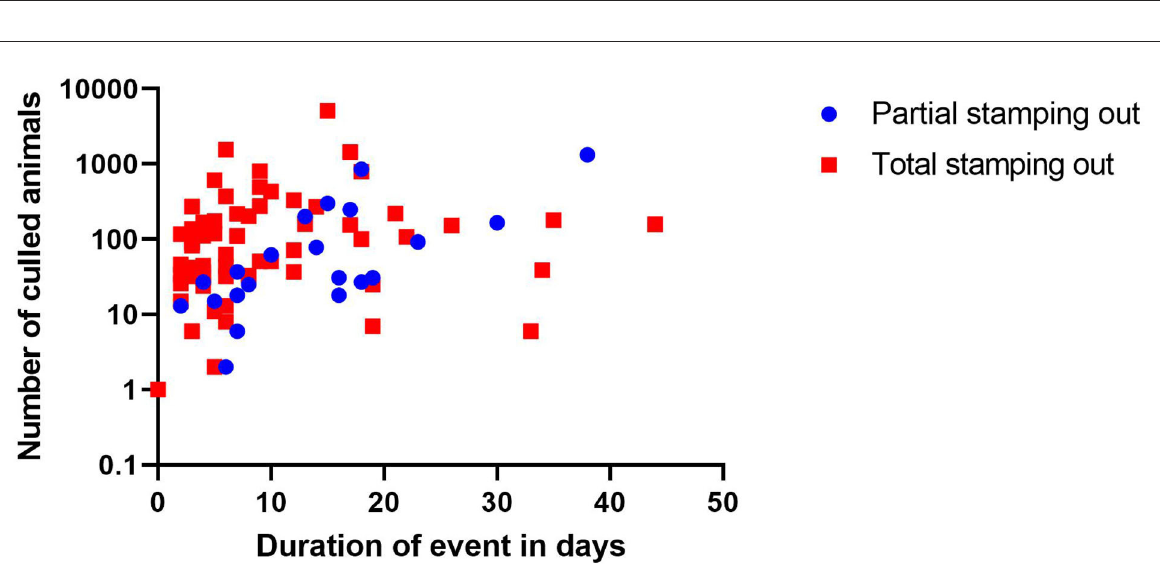
FIGURE3 Scatterplot-depicting time span of the disease event on farm in relation to the absolute number of animals culled per